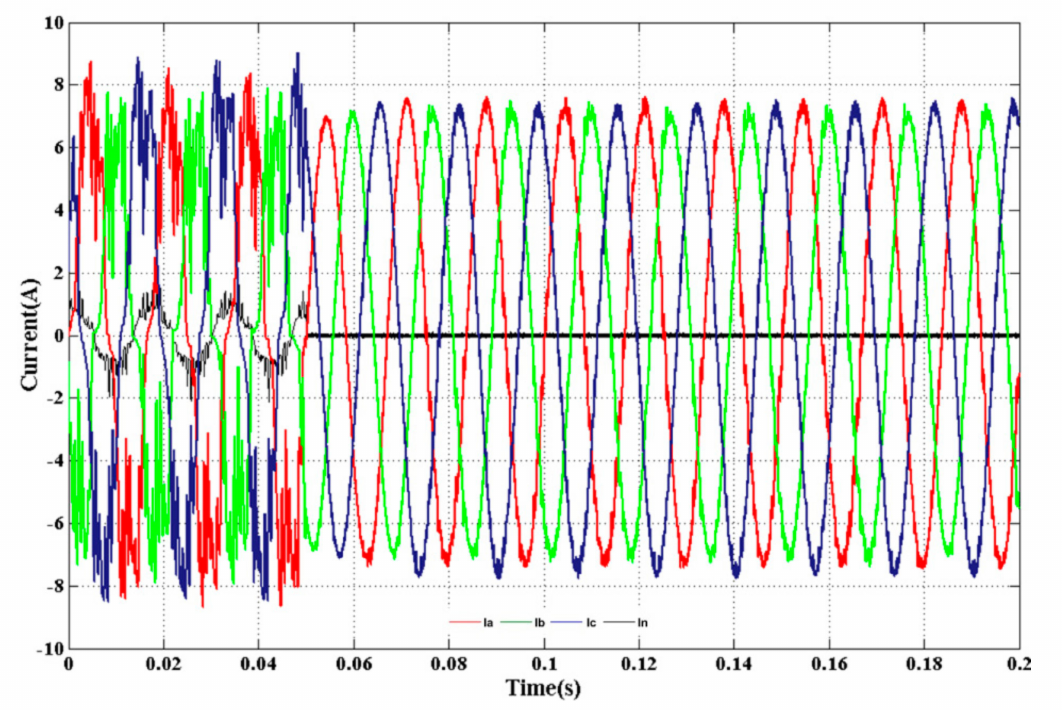
Figure 7. Experimental result of the RNN for case